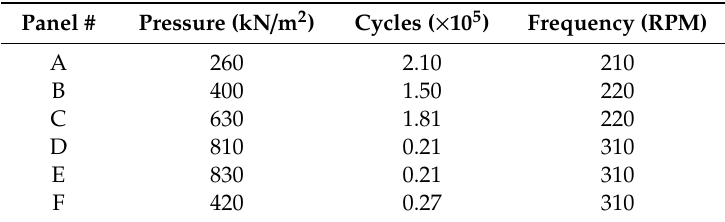
Table 1. Variables used in unmodified panels for slamming tests.